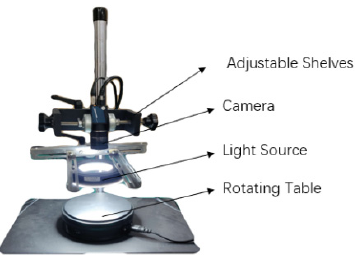
Figure 1. Image acquisition device.